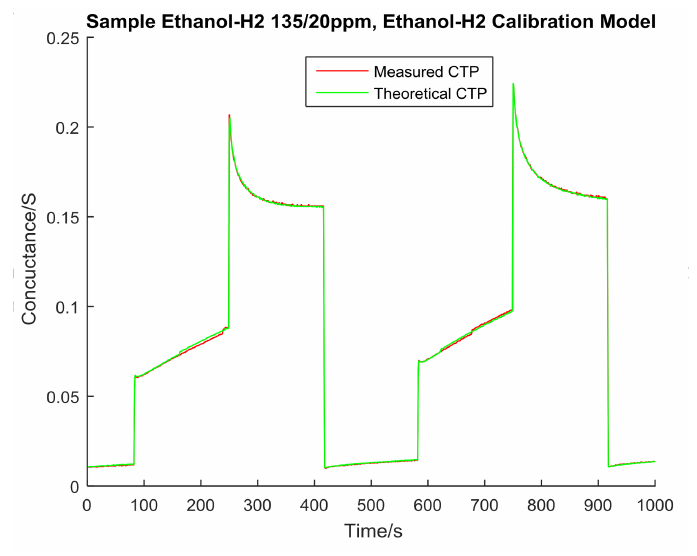
Figure 3. Comparison of measured CTP of a binary ethanol/H 2 mixture and the related theoretical CTP based on the ethanol/H 2 calibration.